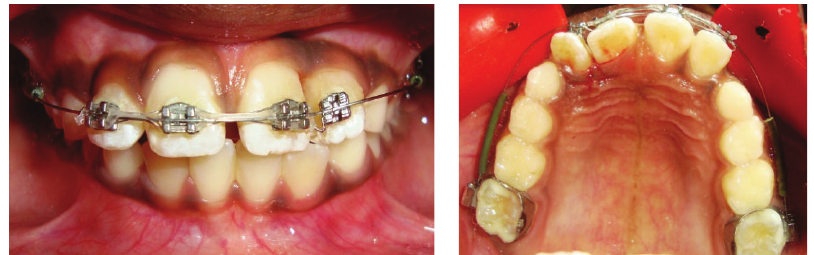
Figure 3: Intraoral view of 2 × 4 fixed appliance.